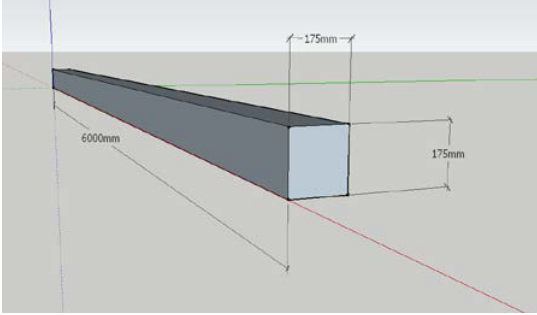
Figure 6. 3D Model for 175mm x 175 mm x 6000